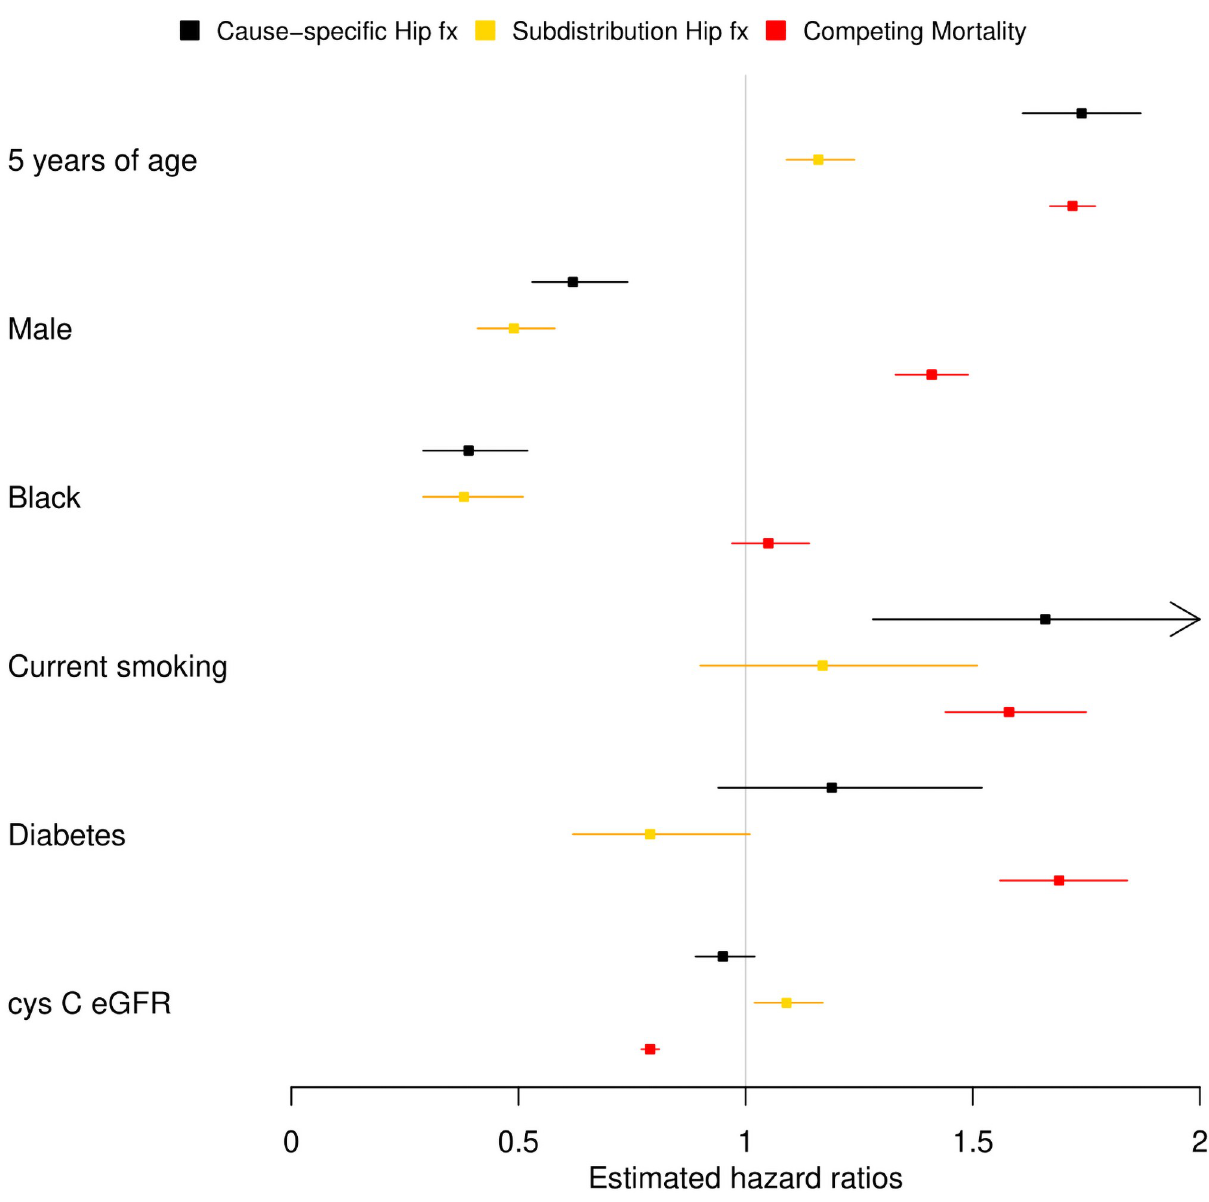
Fig 3. Hazard ratios estimates. Contrasting the hazard ratio estimates for incident hip fracture between the cause-specific approach and the FG subdistribution approach. Mortality cause-specific hazard ratio estimate foretells the mutual position of the hazard ratios for incident hip